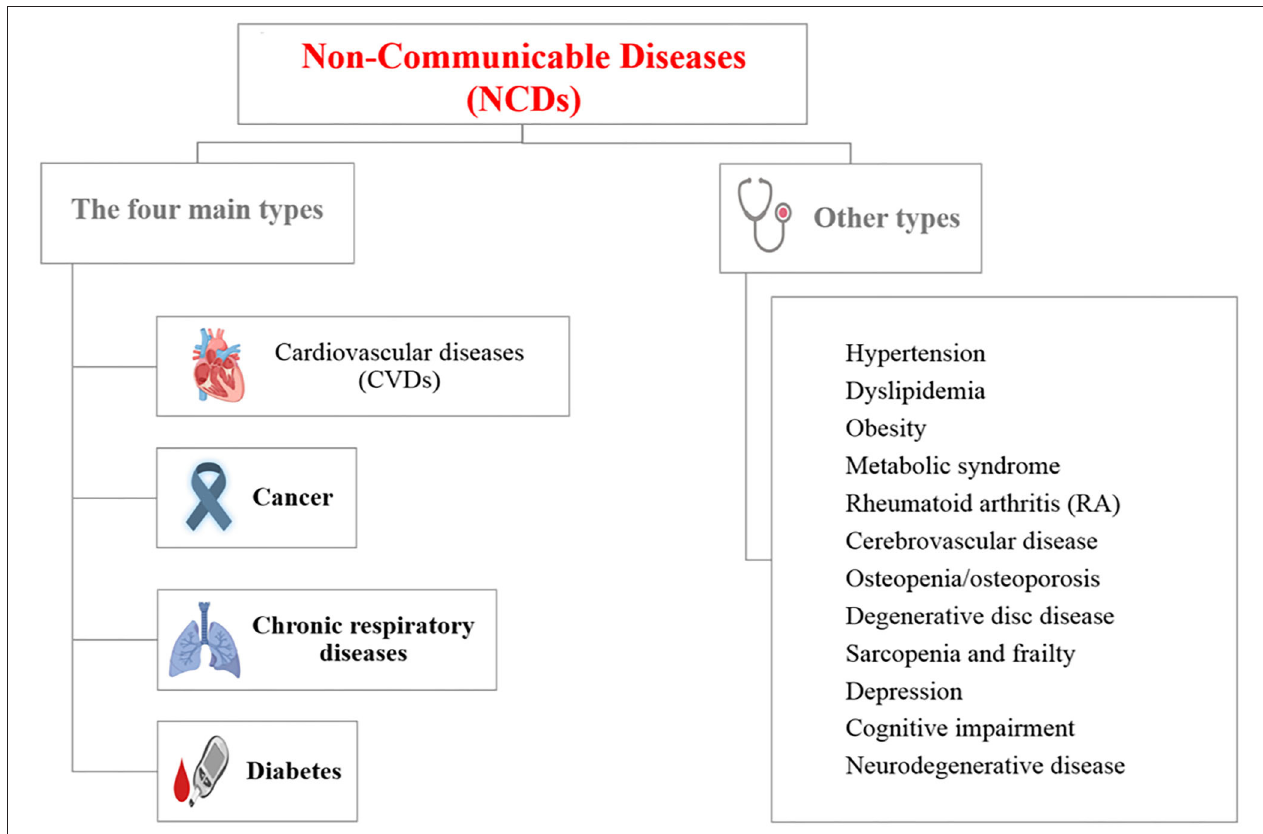
FIGURE 1 | List of non-communicable diseases (NCDs) [Created with BioRender].